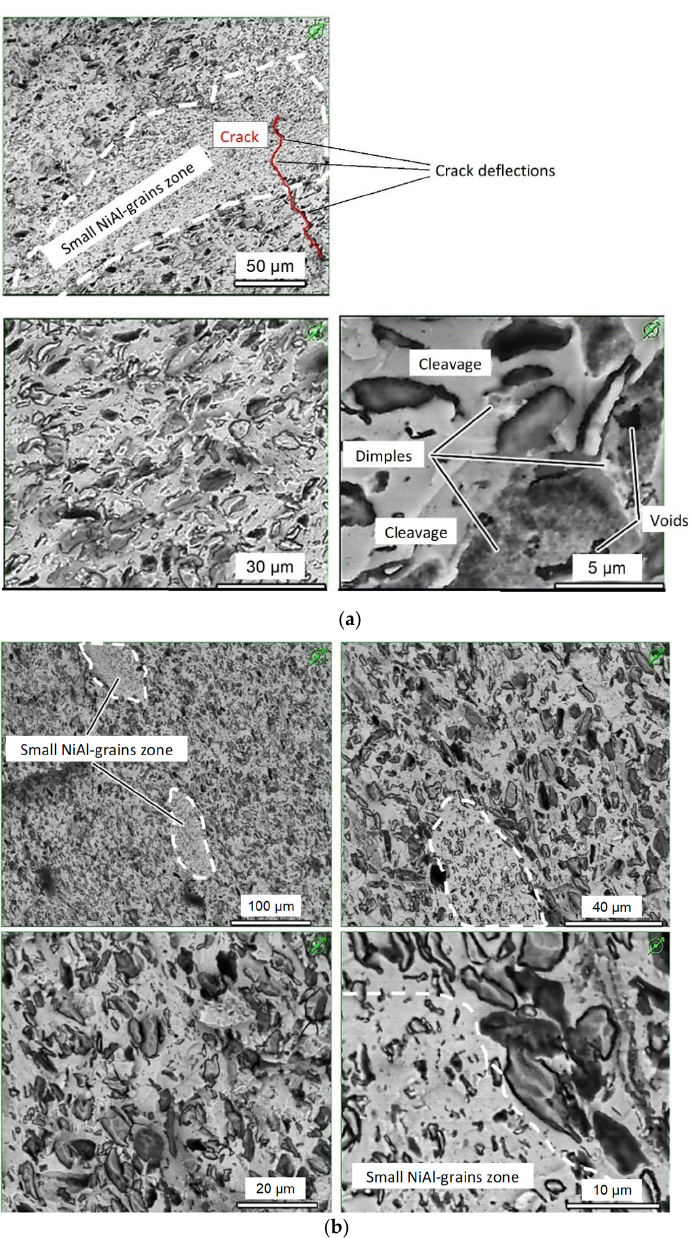
Figure 13. Fracture of alloy with zirconium oxide nanoparticles: ( a ) crack deflection and local ductile fracture, ( b ) small ‐ grains zone.